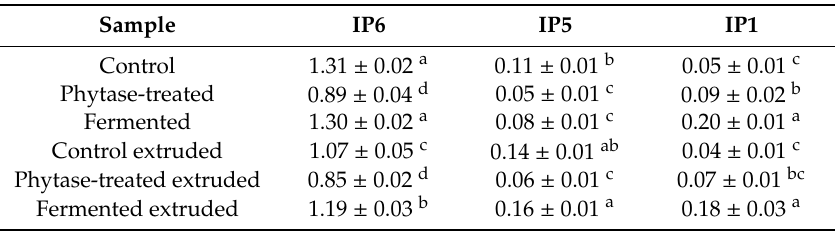
Table 6. Inositol phosphates content [% dwb] measured with the LC-MS method in treated powders and extrudates. Standard deviations are shown ( n = 3). Values sharing a letter within a column are not statistically di ff